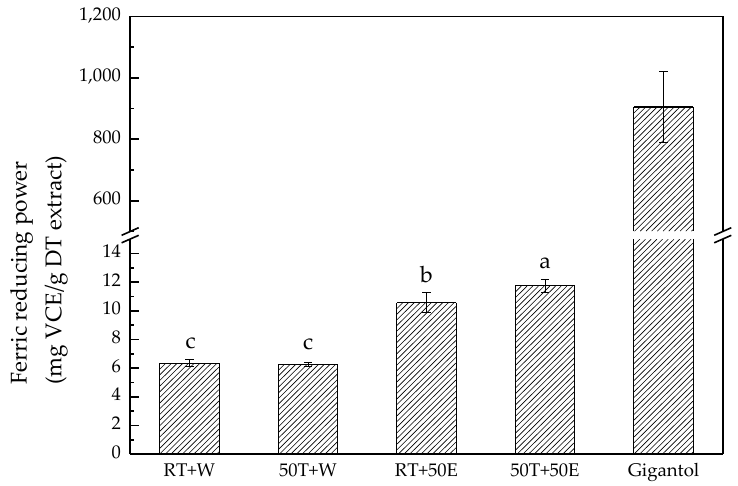
Figure 6. Ferric-reducing power of the four extracts and gigantol. Treatment means with the same letter are not significantly different.